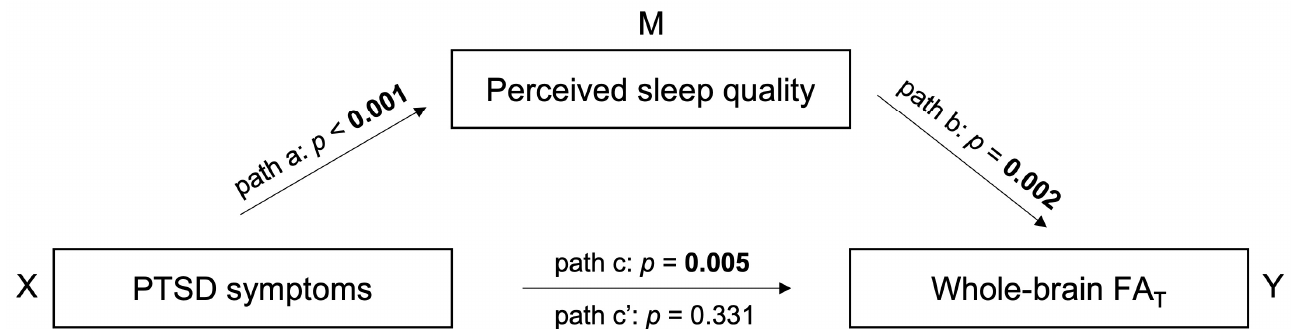
Figure 3. Mediation model. Note. PTSD, post-traumatic stress disorder; mTBI, mild traumatic brain injury; FA T , fractional anisotropy tissue. This figure illustrates the mediating effect of perceived sleep quality between PTSD symptom severity and whole-brain FA T . Path a refers to the association between X and M. Path b refers to the association between M and Y when taking X into account. Path c represents the total effect of X on Y, including the axb path. Path c’ shows the direct effect of X on Y when M is omitted.